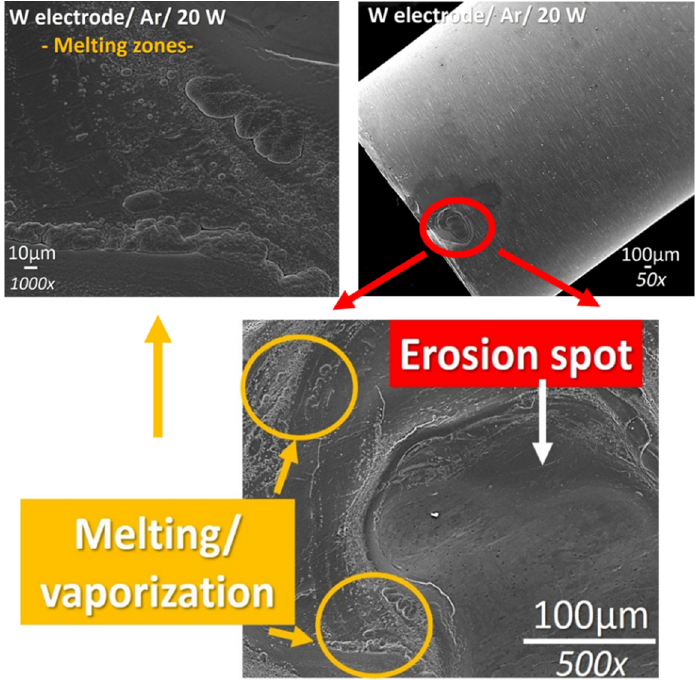
Figure 6. Example of erosion/melting/vaporization damage of W electrode exposed at a microjet discharge in Ar at Prf = 20 W, p = 1000 mbar, t = 30 min.